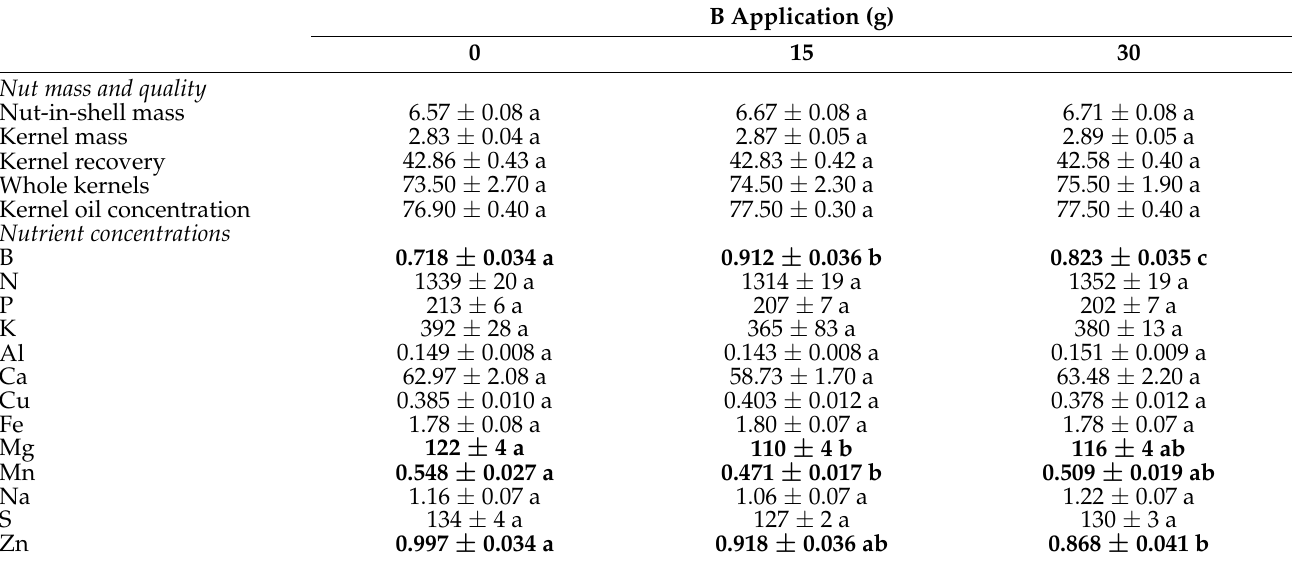
Means ± SE within a row with bold font and different letters are significantly different (generalised linear models, p < 0.05, n = 200 nuts for NIS mass, kernel mass, kernel recovery and kernel oil concentration, n = 10 trees for whole kernel incidence, n = 100 nuts for mineral nutrient